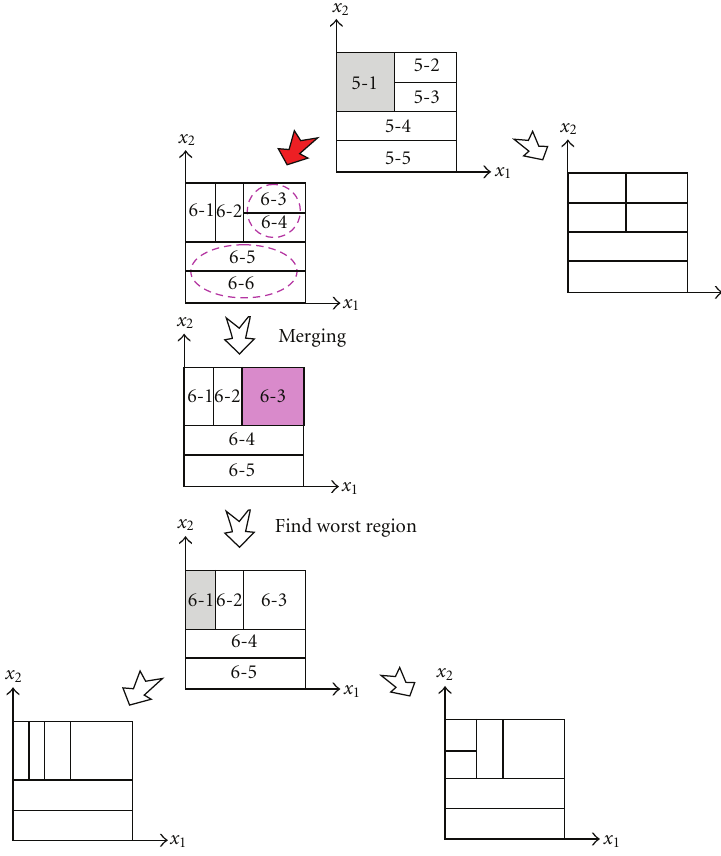
Figure 2: Self-construction ability in PiLiMoT algorithm with merging in 6th